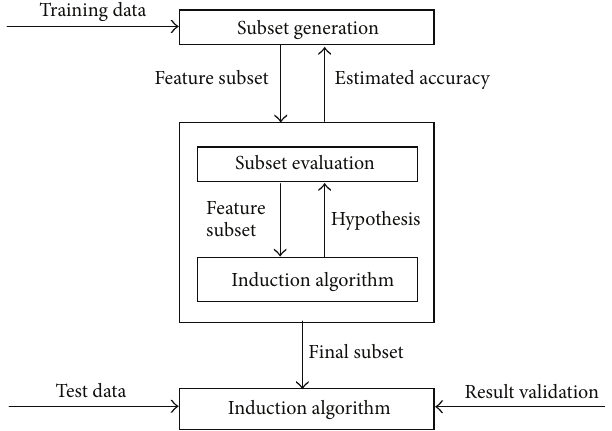
Figure 2: The wrapper approach for feature selection